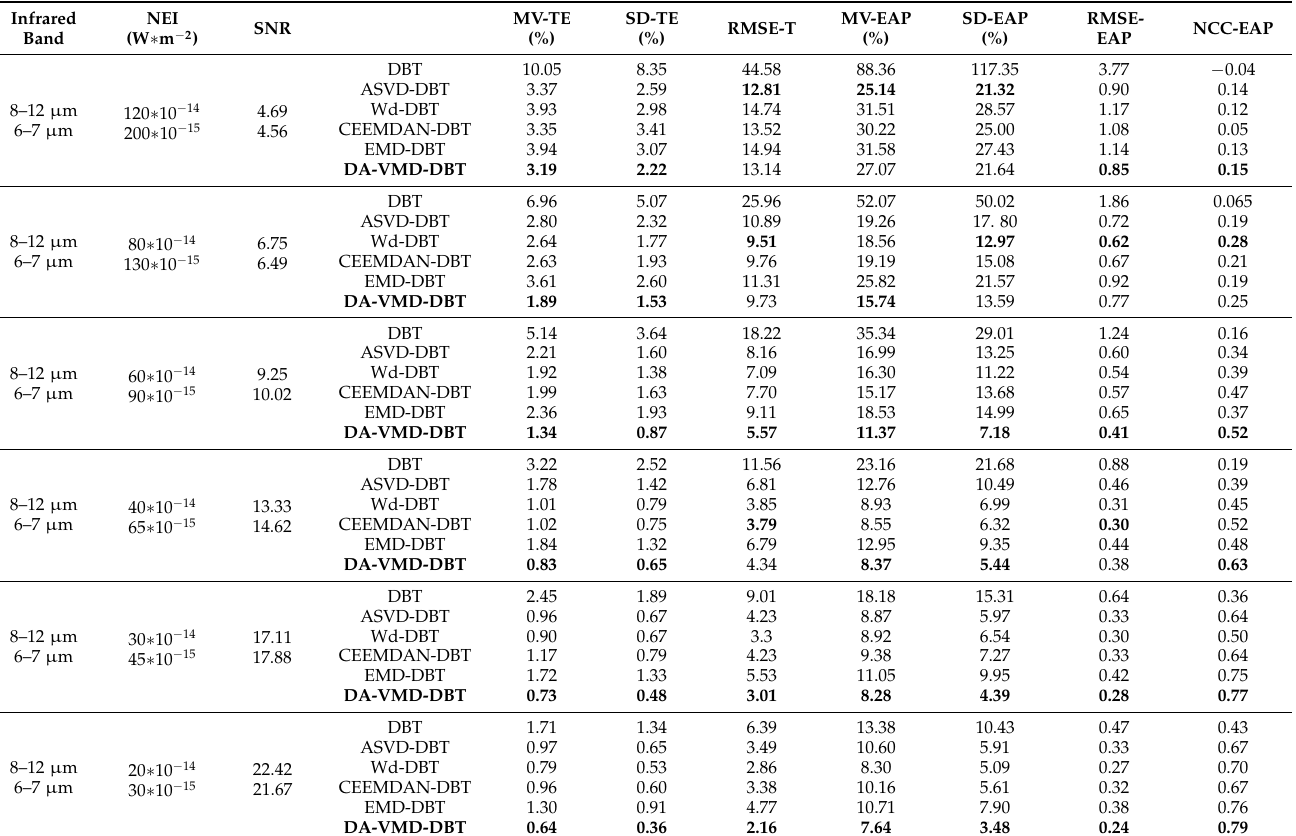
Table 7. The results of evaluation indexes of the feature extraction of simulated radiation signal (8–12/6–7 µ